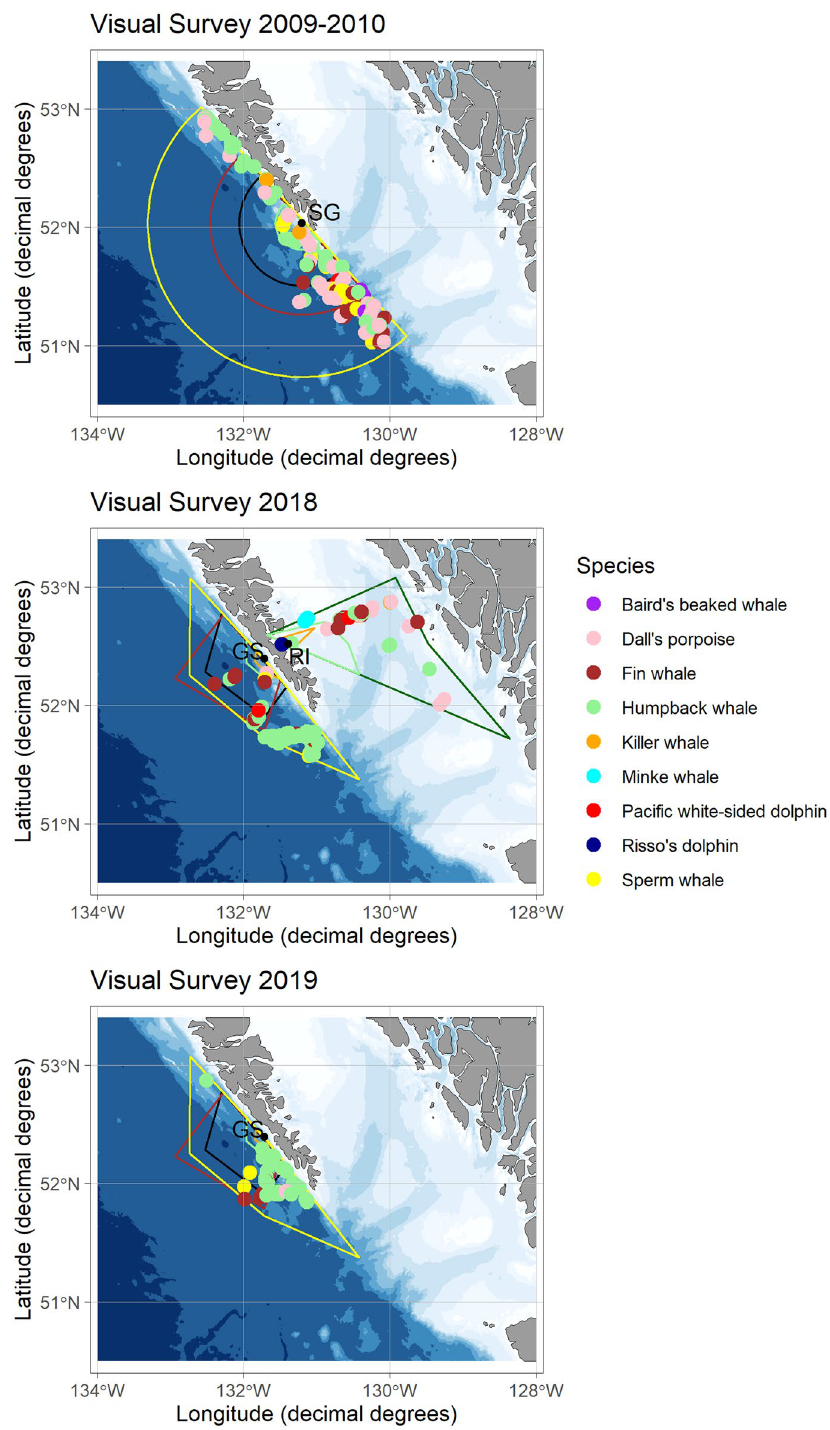
Figure 2. Cetacean sightings by species (colored dots) within the detection range of each hydrophone (black dots) during each summer visual survey, and summer detection ranges (colored lines) for each species in the study area (top: 2009–2010; middle: 2018; and bottom: 2019). Detection ranges of RI for both gray whale and fin whale were identical. Pacific white-sided dolphin had the smallest detection range from RI (< 2.4 km; not visible on the map). Maps were created using the ggOceanMaps package (version 1.26) in R 122